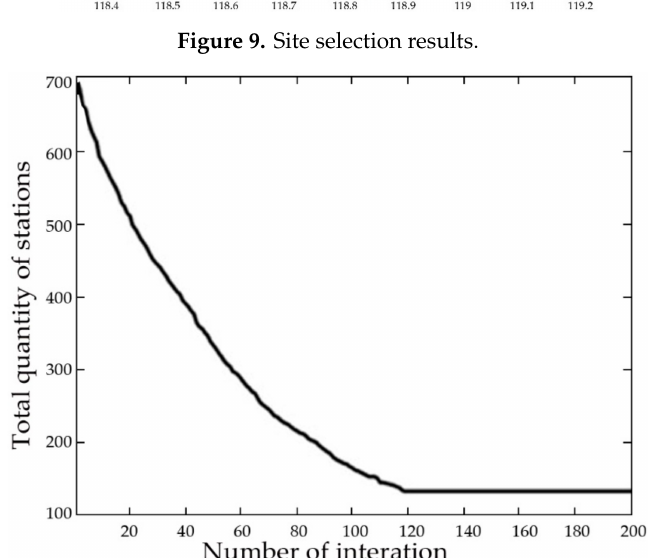
Figure 10. Iterative computation in